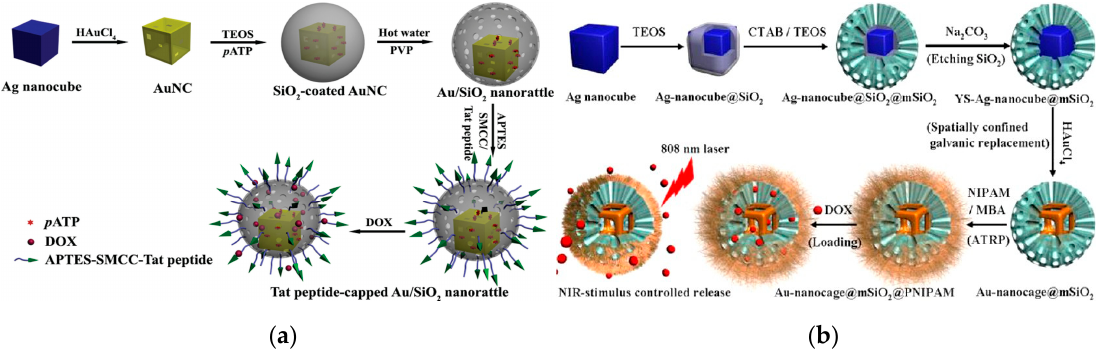
Figure 4. ( a ) Schematic diagram of the synthesis of the double-walled Au/SiO 2 nanorattles. Reproduced with permission from [71]. Copyright small, 2015; ( b ) Fabrication of the Au nanocage@mesoporous SiO 2 core-shell structure for NIR-stimulus controlled drug release. Reproduced with permission from [72]. Copyright Chemistry of Materials, 2013.